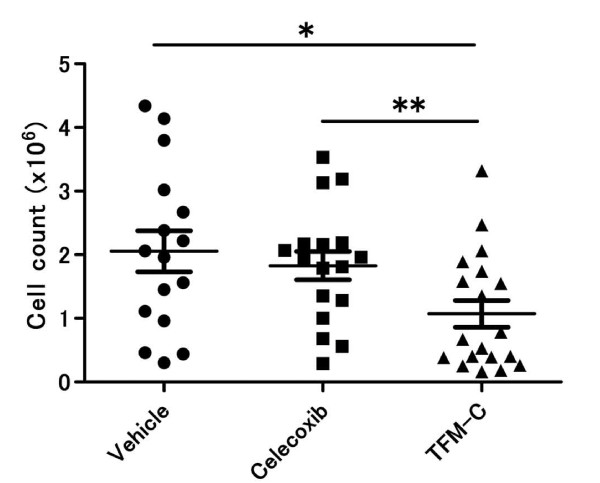
TFM-C supresses leukocyte influx in thioglycollate-induced peritonitis. B6 mice recieved 10 μg/g TFM-C, celecoxib or vehicle at two days and one hour before peritoneal injection of thioglycollate. At four hours after thioglycollate injection, peritoneal lavage fluid was collected and the infiltrating cells were counted. Cell numbers are shown from three separate experiments. * P < 0.05, TFM-C-treated versus vehicle-treated group. * P < 0.05, celecoxib-treated versus TFM-C-treated group.